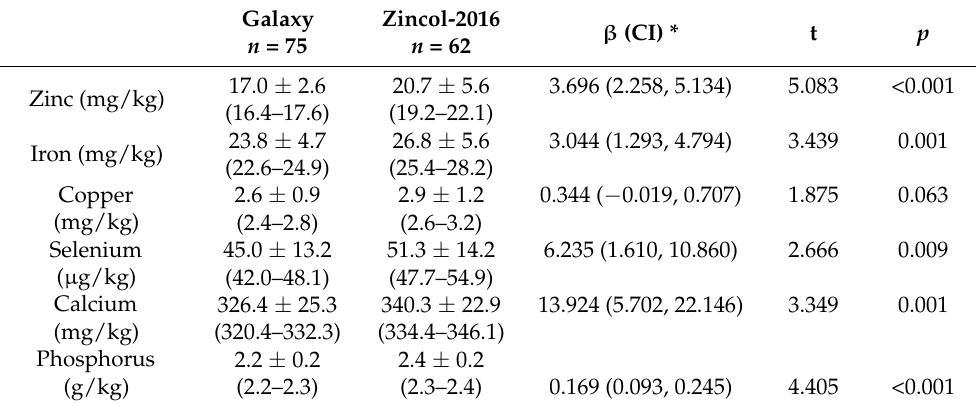
Table 3. Comparative summary of the mineral content for two varieties of wheat